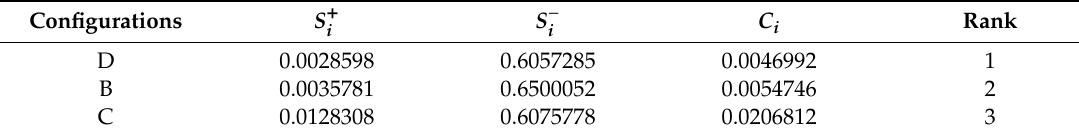
Table 11. Relative closeness to ideal solution based on SIMOS